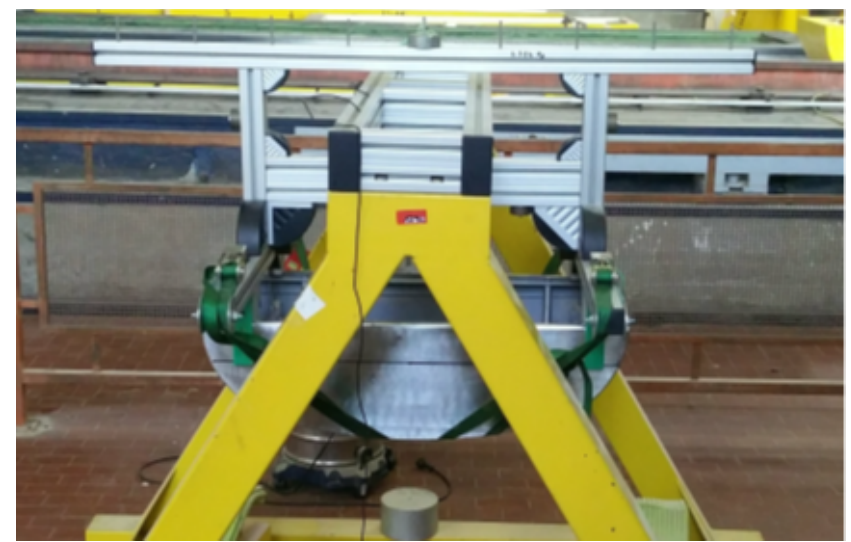
Figure 5. ISWEC center of gravity and moments of inertia and measurement through the inertial balance. Table 1. ISWEC full-scale and scaled prototype